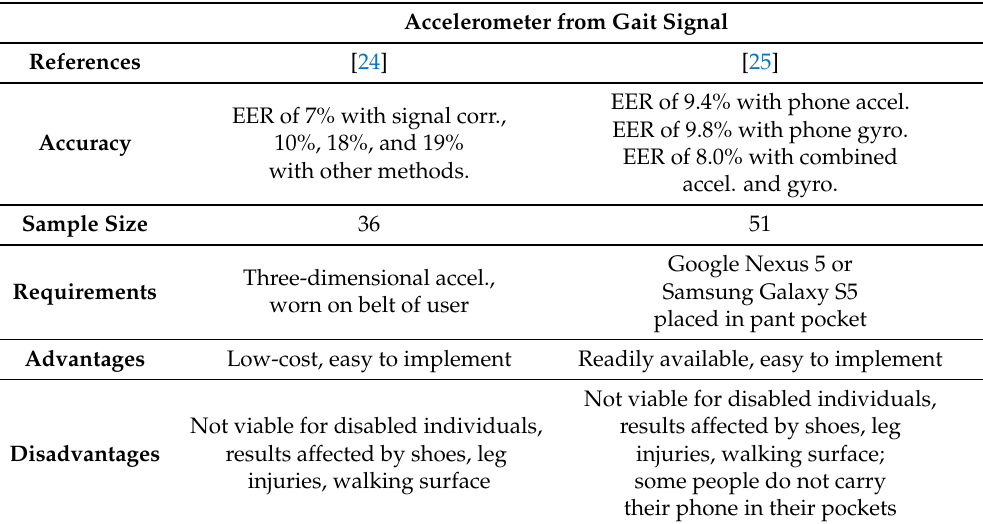
Table 7. Body Portable Device Evaluation by